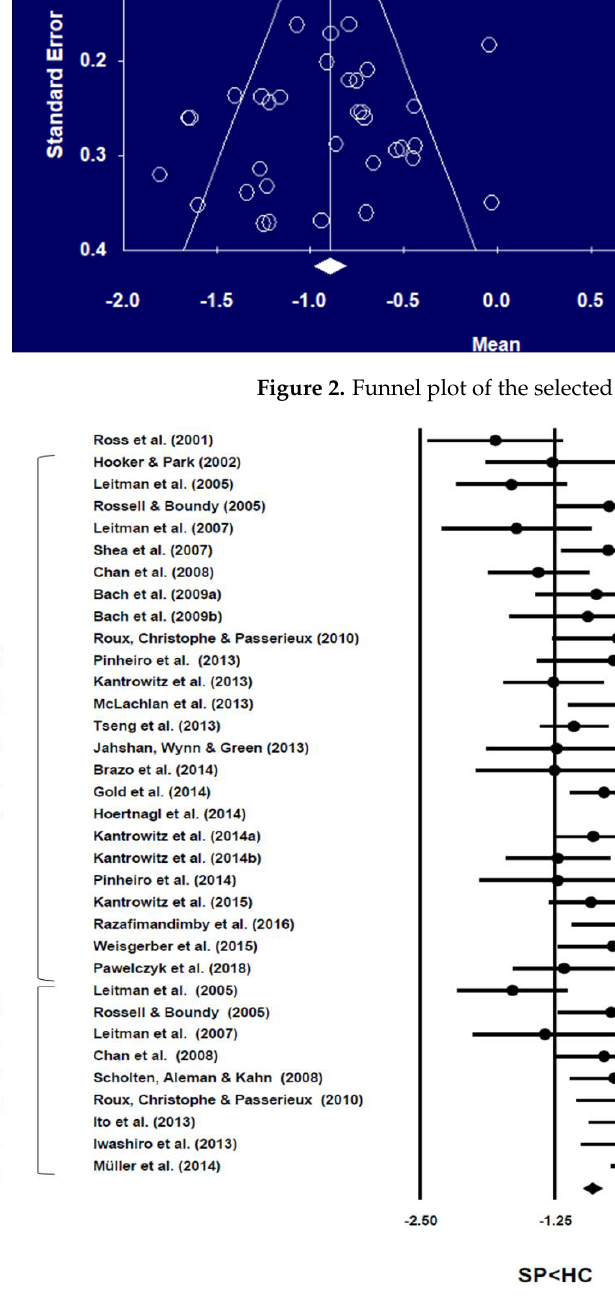
Figure 3. Forest plot with effect size ( d ) and confidence intervals for the selected studies. Note: Ross et al.’s study (2001) only reported the results of comprehension tasks, thus excluded from the meta-analysis of both identification and discrimination paradigm but included in the overall effect size calculation.